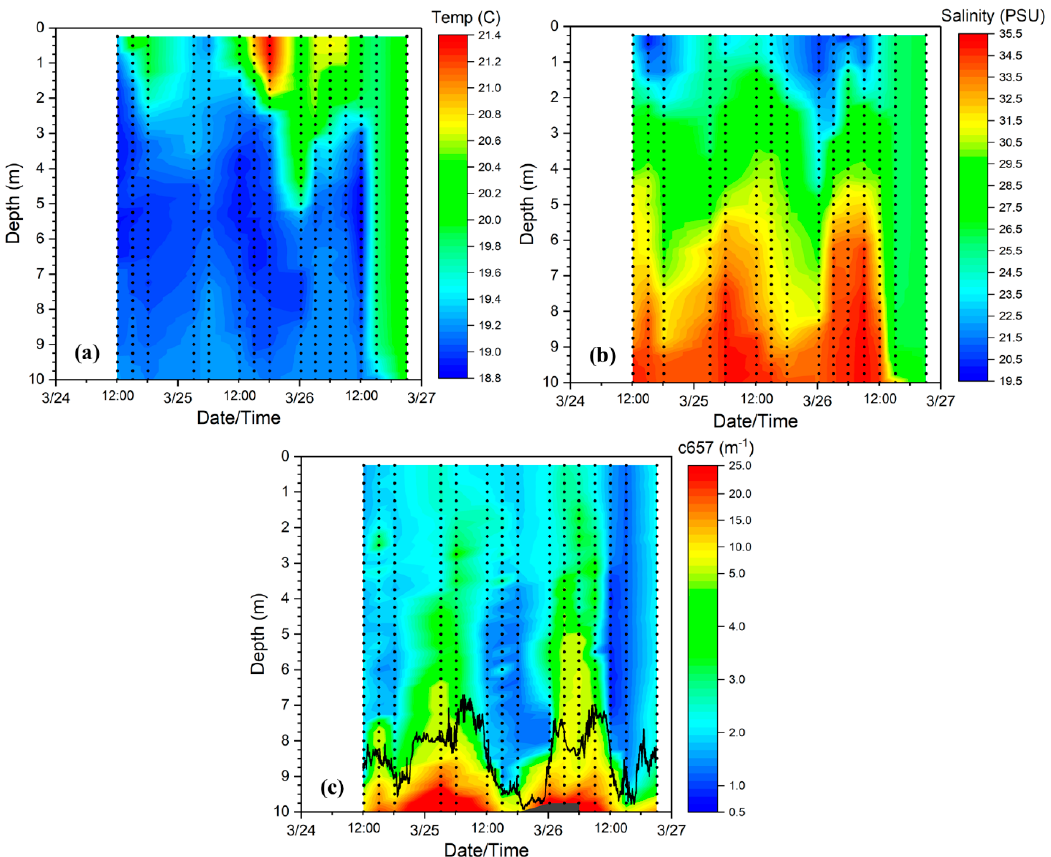
Figure 10. Vertically-resolved time series from mooring BP2 (profiling mooring). The black dots represent the spatial (vertical) and temporal sampling resolution. ( a ) Temperature; ( b ) Salinity; ( c ) Beam attenuation coefficient, c(657). The black line indicates echo intensity data from the ADCP (arbitrary scale). Times indicated are local (UTC — 5 h).